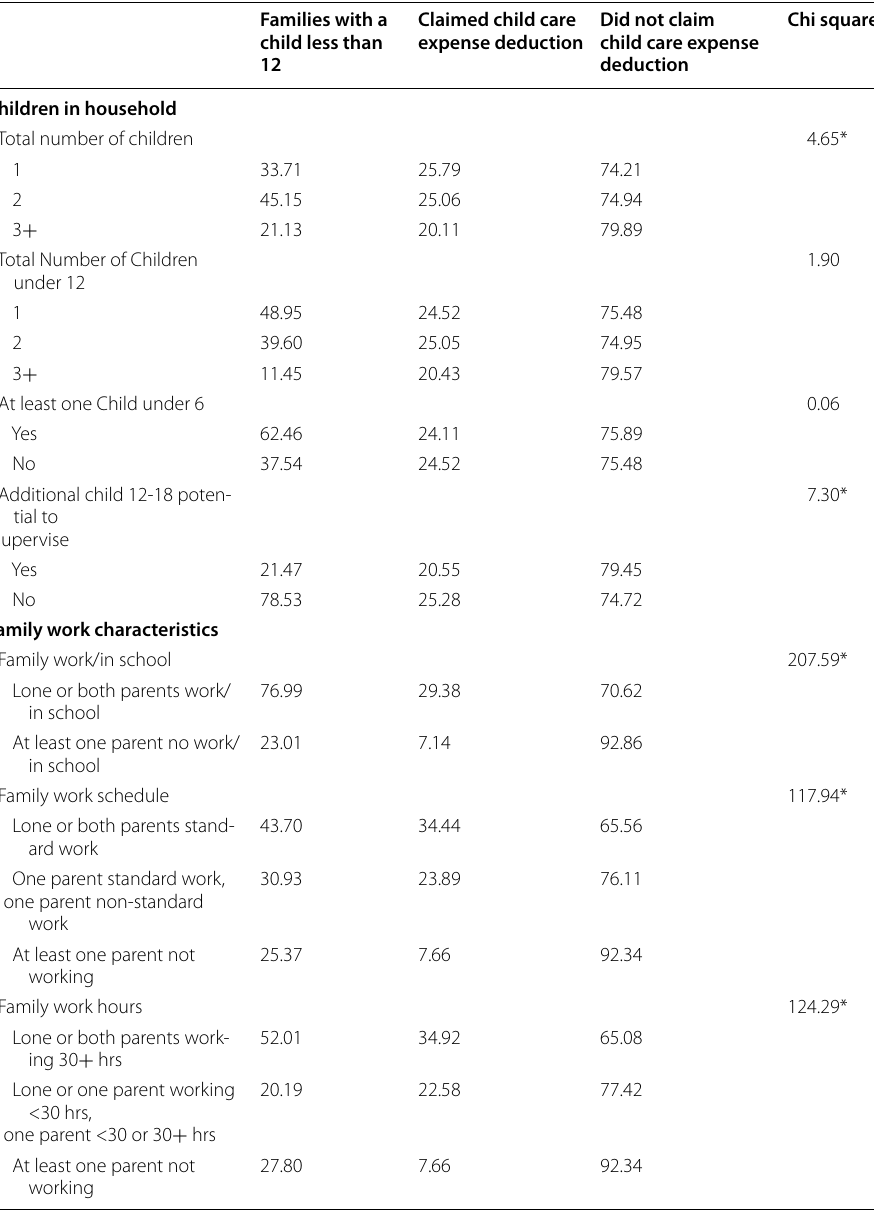
Table 2 presents results from the logistic regression model predicting whether or not families claim the child care expense deduction among all families with a child under the age of 12 controlling for differences in key demographic, child